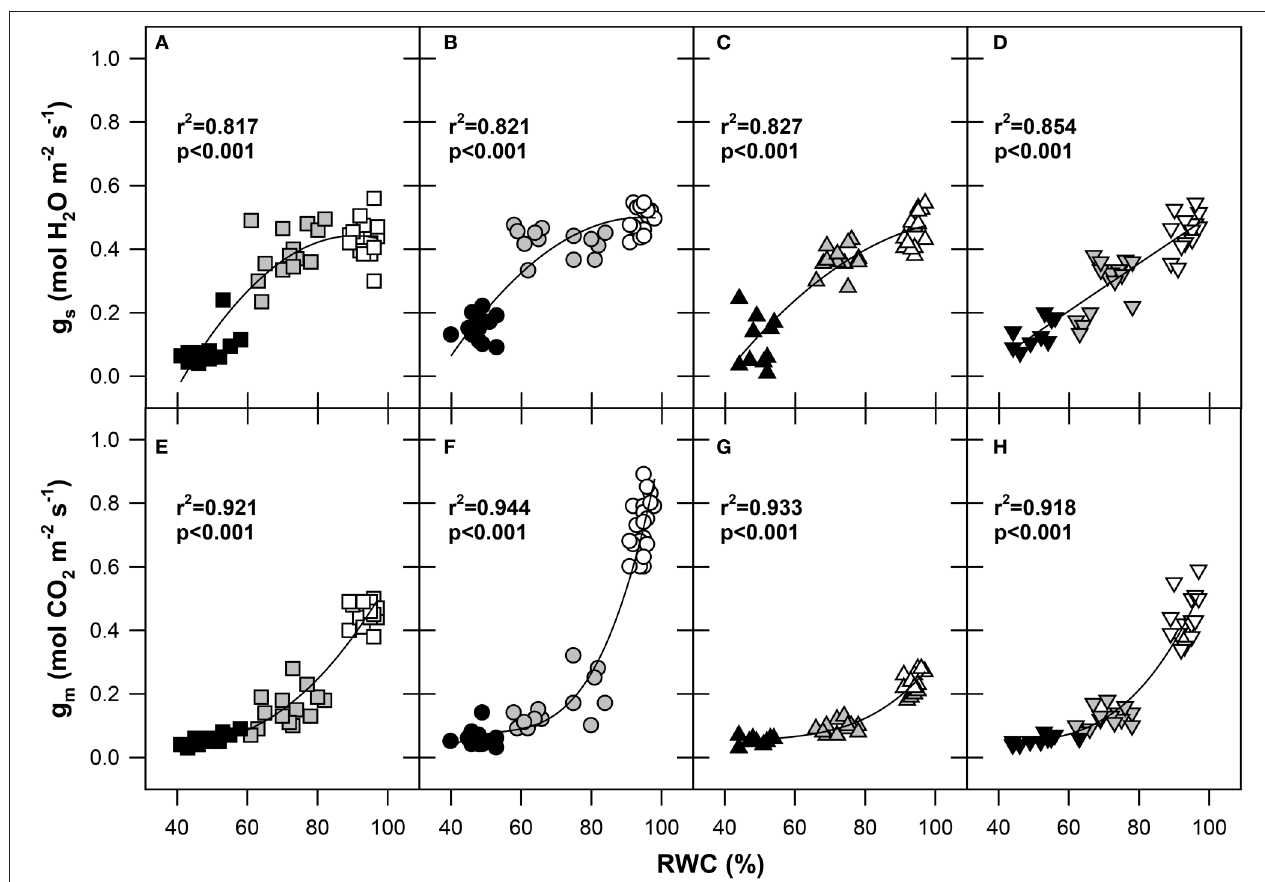
FIGURE 2 | Responses of stomatal conductance to H 2 O (g s ; mol H 2 O m − 2 s − 1 ) and mesophyll conductance to CO 2 (g m ; mol CO 2 m − 2 s − 1 ) to the relative water content (RWC; %) of flag leaves in four wheat genotypes (A, E) GK Forrás, (B, F) Pehlivan, (C, G) Piopio-4 and (D, H) Šamorínska. The points represent individual measurements of leaves. Symbols: square-GK Forrás, circle-Pehlivan, up-triangle-Pio, down-triangle–Šamorínska; empty symbols–well-watered (RWC 80–100%) plants, gray symbols-mild stress (RWC 60–80%) and black symbols-severe stress (RWC 40–60%). The coefficients of determination ( r 2 ) and significance level ( p ) as well as the lines of polynomial quadratic (A–D) and polynomial cubic (E–H) regressions are